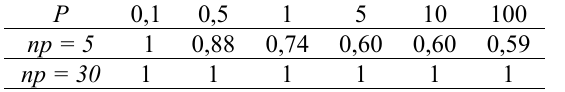
Fig. 4 – Influence of the standard deviation ω with (Purely